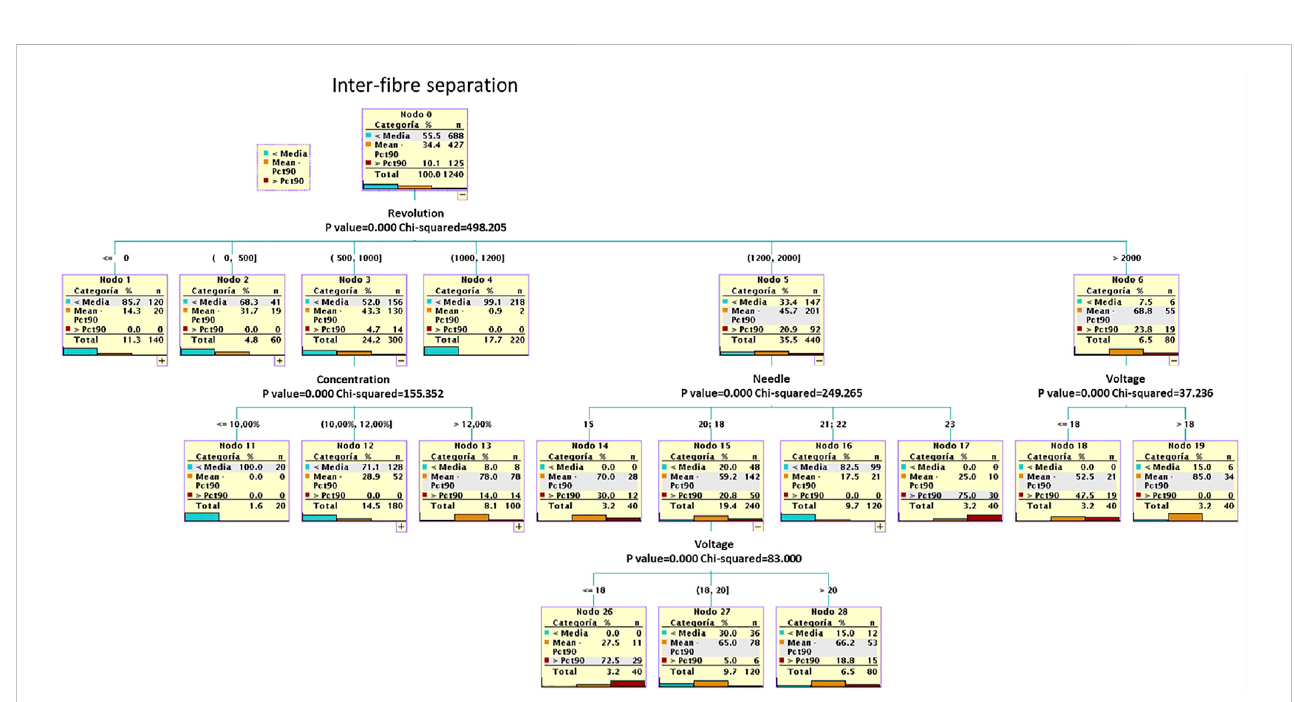
FIGURE 3 Decision tree to predict inter- fi bre separation based on the most relevant